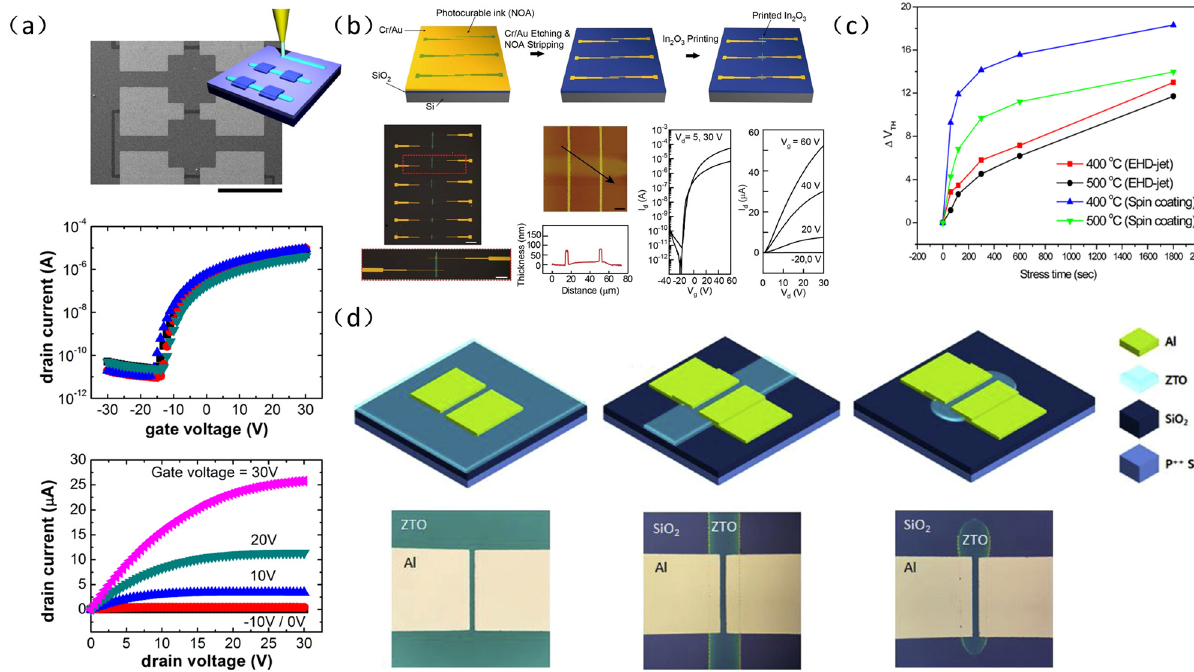
Figure 13: ( a ) The electrical characteristics of E - jet printed IZO TFTs. Reproduced from ref. [ 146 ] with permission from American Institute of Physics. ( b ) The electrical characteristics of E - jet printed IZO TFTs. Reproduced from ref. [ 143 ] with permission from Royal Society of Chemistry. ( c ) Comparison chart of threshold voltage o ff set over time for E - jet printing and spin coating processes. Reproduced from ref.